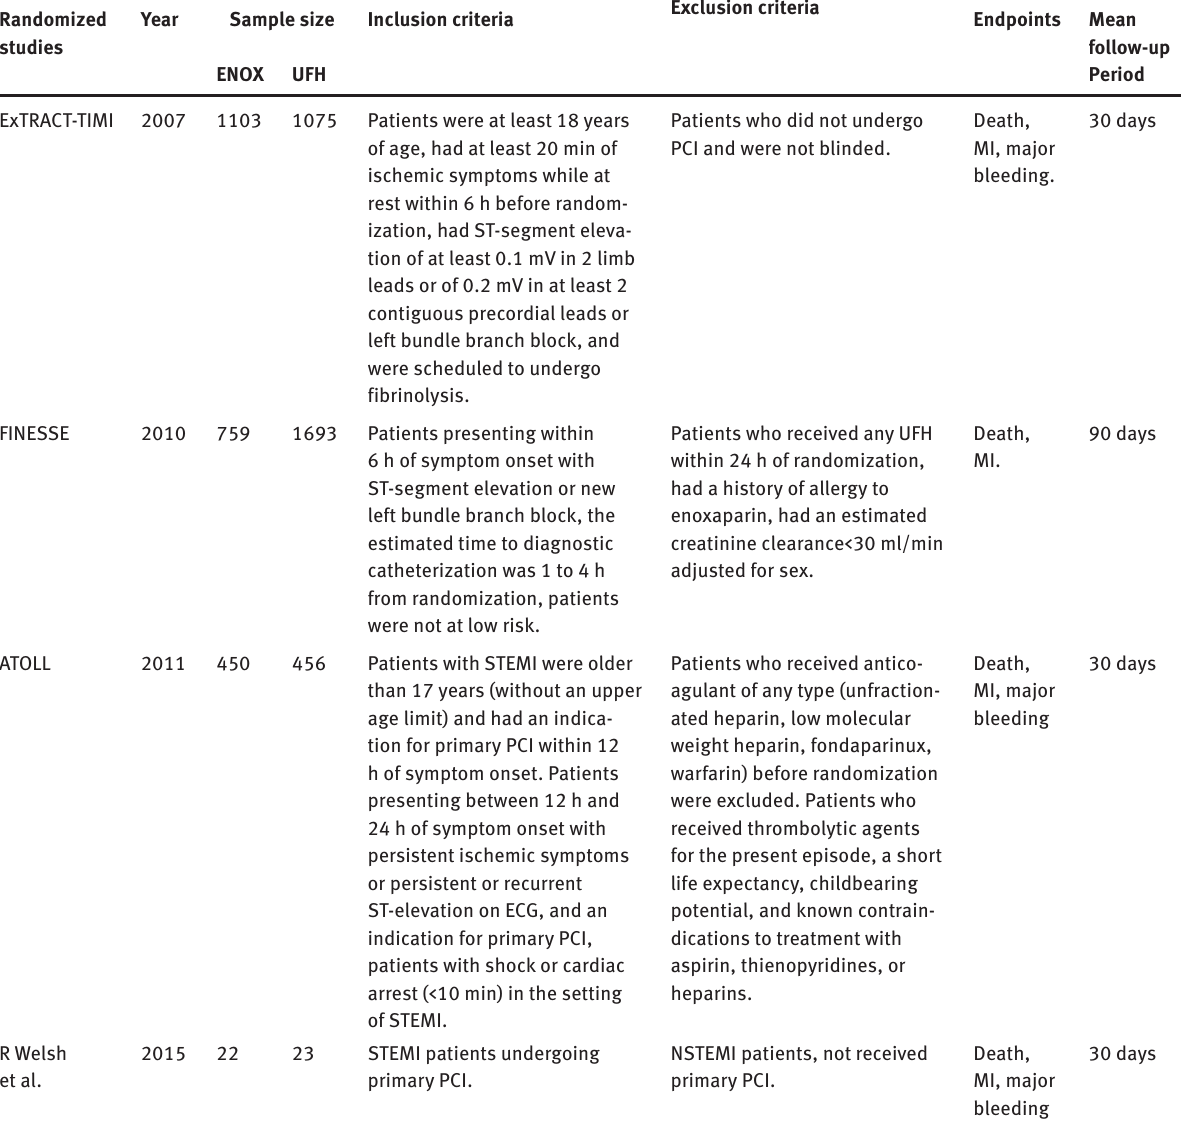
Table 1: Characteristics of randomized studies.